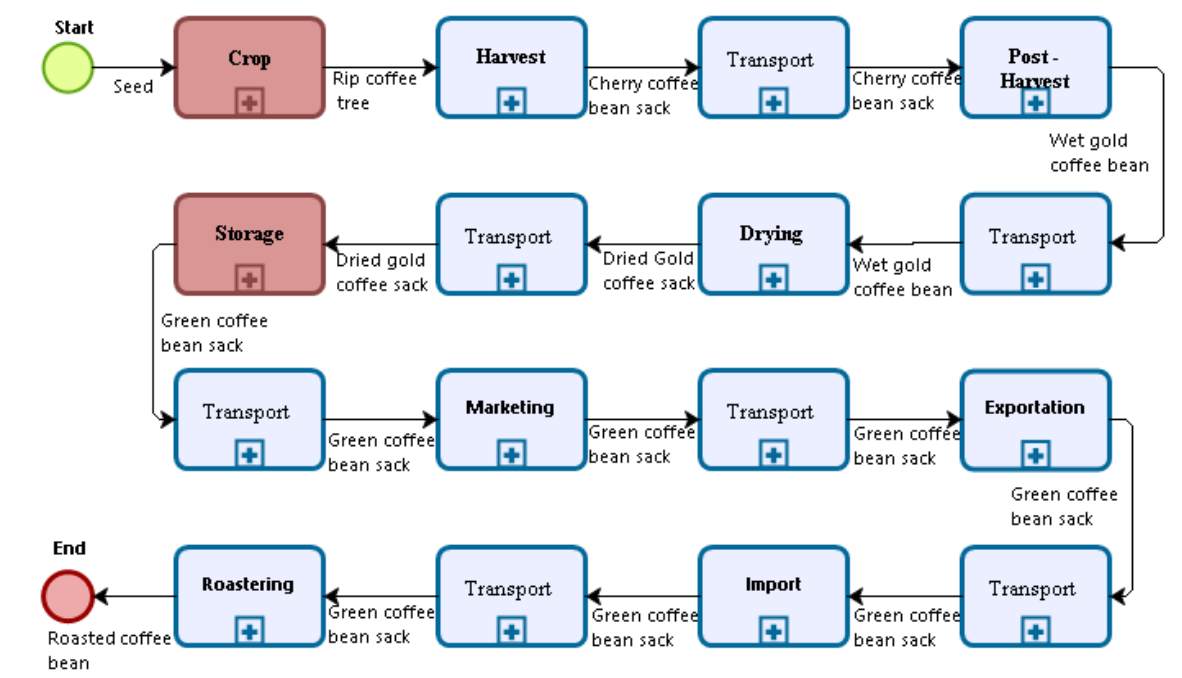
Figure 8. BPMN Coffee value chain.